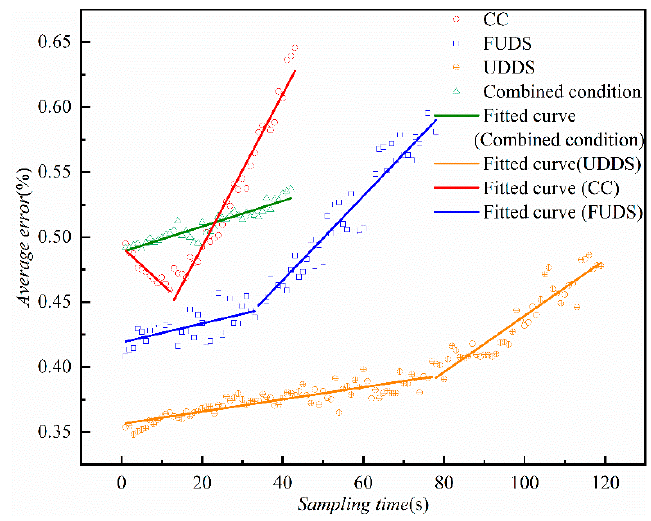
Figure 8. The relationship between sampling time and the mean absolute error (25 °C).